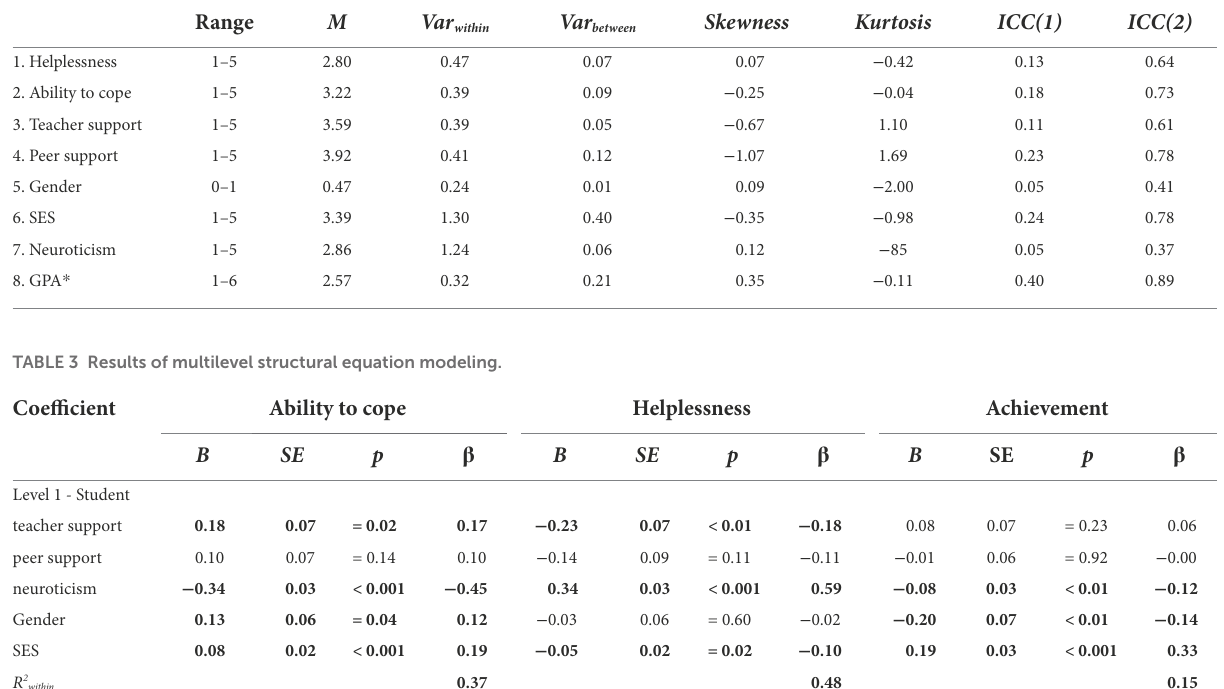
TABLE 2 Descriptive statistics.